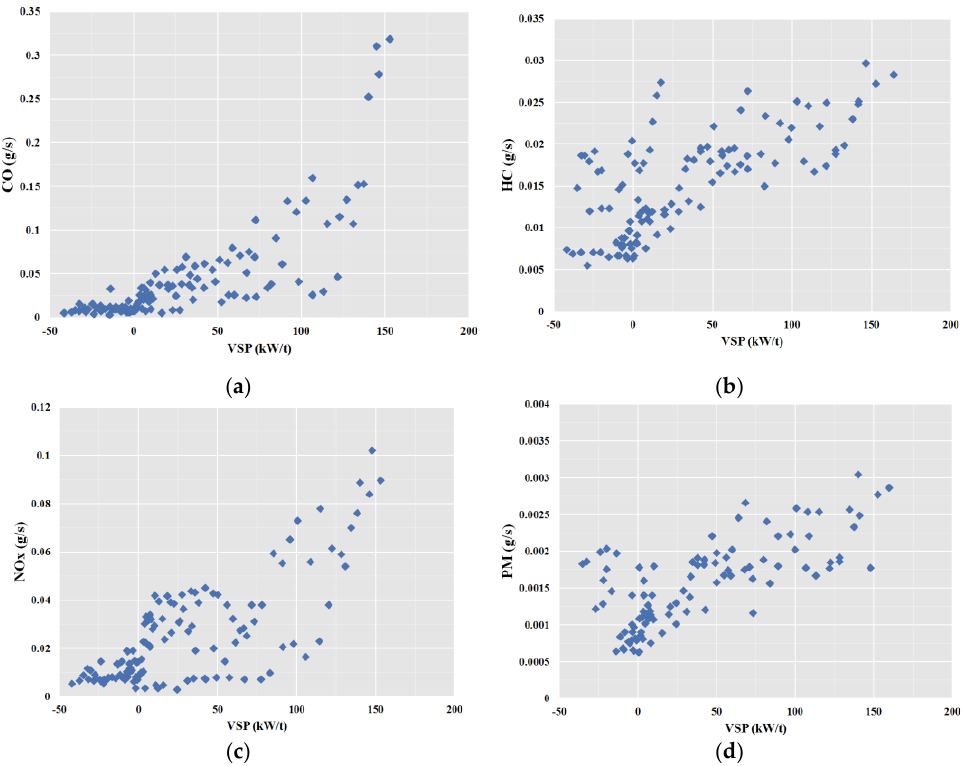
Figure 7. The typical relationship between vehicular VSP and pollutant emission rate. ( a ) The relationship between vehicular VSP and CO emission rate; ( b ) The relationship between vehicular VSP and HC emission rate; ( c ) The relationship between vehicular VSP and NOx emission rate; ( d ) The relationship between vehicular VSP and PM emission rate.